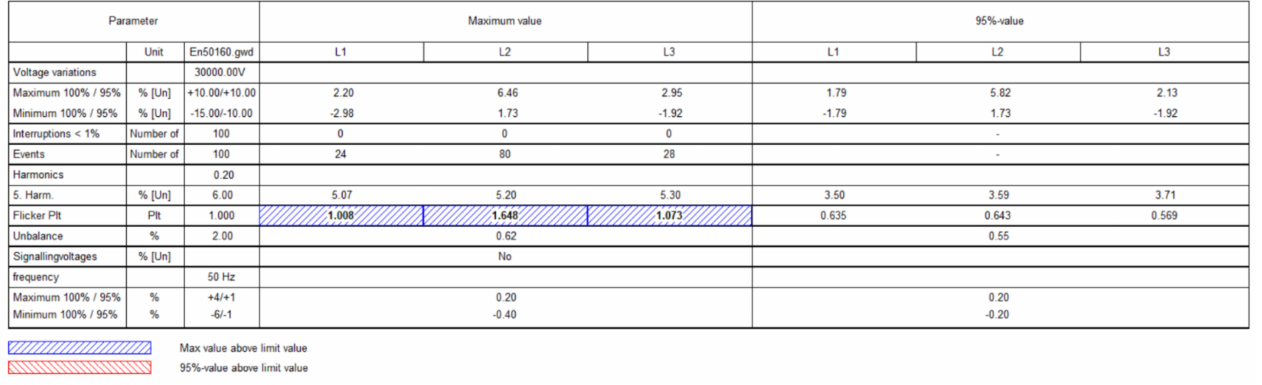
Figure 11. Sumary presentation of power quality indicators measured in the supply line traction substation—Point